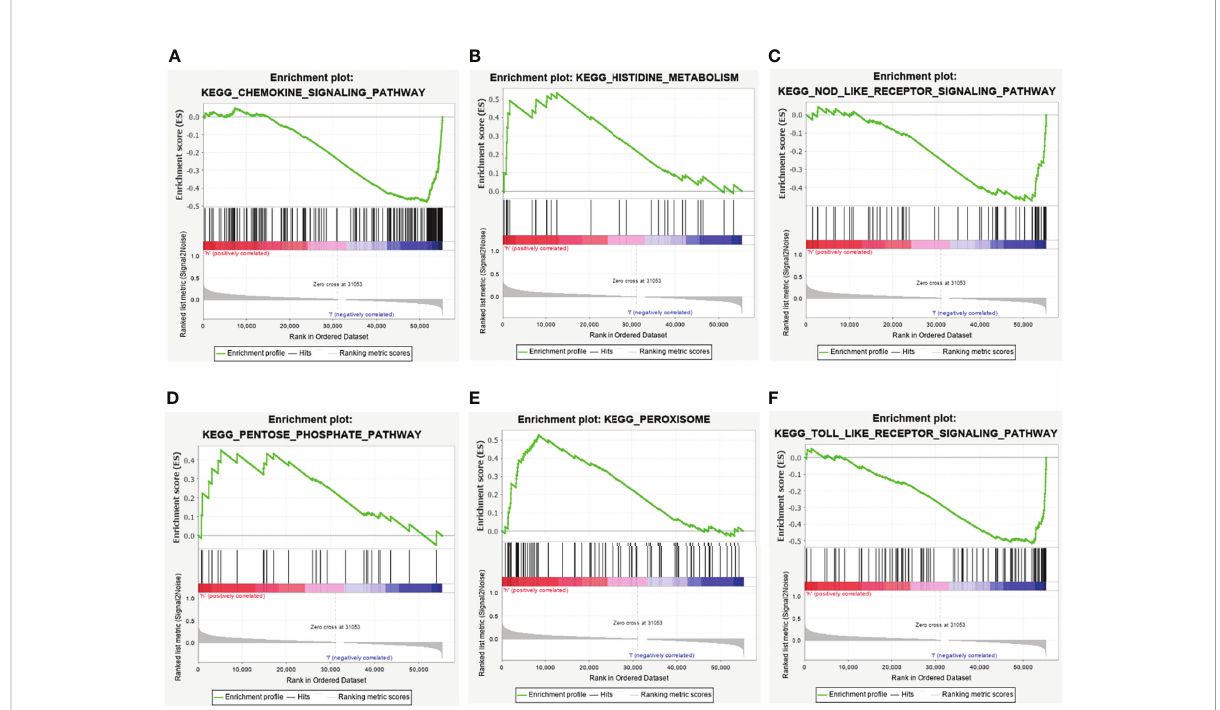
FIGURE 7 GSEA pathway enrichment analysis of metabolism-related lncRNAs. (A) Chemokine signaling pathway. (B) Histidine metabolism. (C) NOD- like receptor signaling pathway. (D) Pentose phosphate pathway. (E) Peroxisome. (F) Toll like receptor signaling pathway.